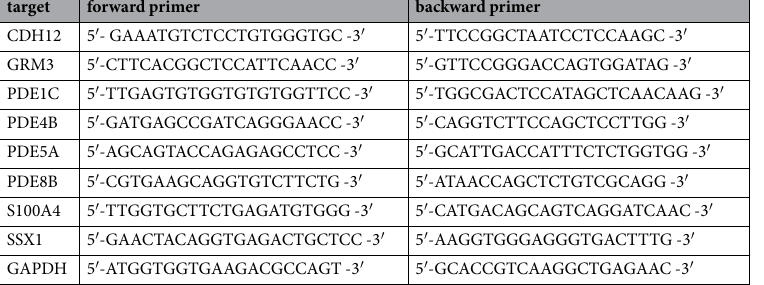
Table 2. Real-time qPCR primers used in this